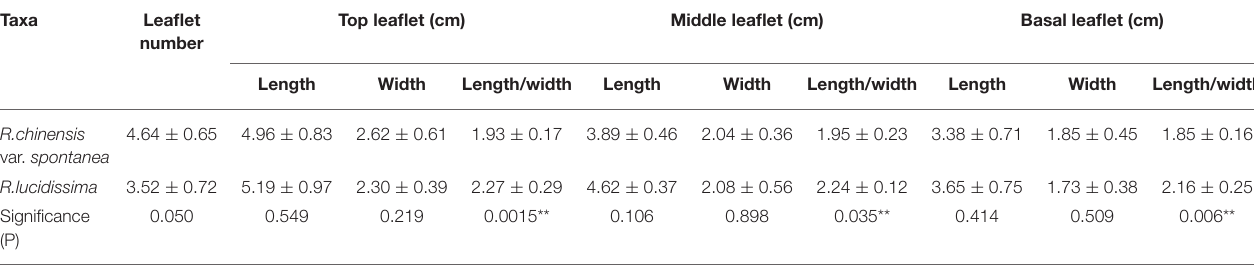
TABLE 3 | Comparison of compound leaves between Roa chinensis var. spontanea and Rosa lucidissima . Taxa